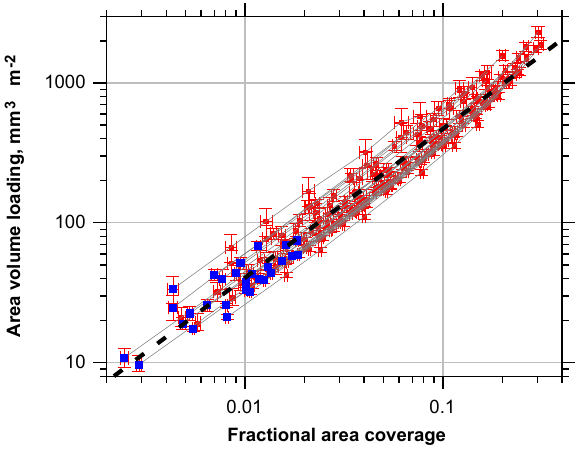
Figure 7. Particle volume per area calculated from single parti- cle measurements as function of the fractional area coverage. Blue symbols denote the unmodified samples, red symbols the simula- tion of higher coverage by factors of 2, 3, 5, 10, 15 and 20. Error bars denote the two-sided 95% confidence interval. The fit function shown as black dashed line is calculated as y = exp (a ln (x) + b) ; (cid:2) y (cid:3) = mm 3 m − 2 ; a = 0 . 957 ± 0 . 041; b = 3 . 57 ± 0 . 06; x is the frac- tional area